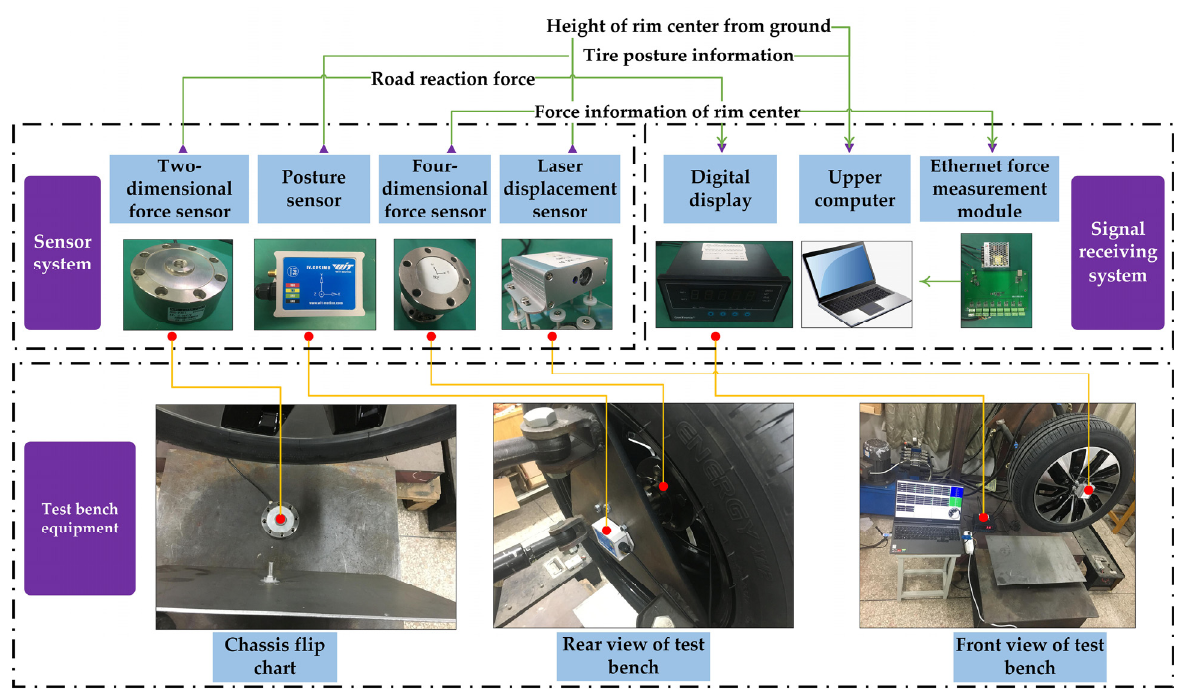
Figure 5. General frame diagram of the finite element tire model verification system.